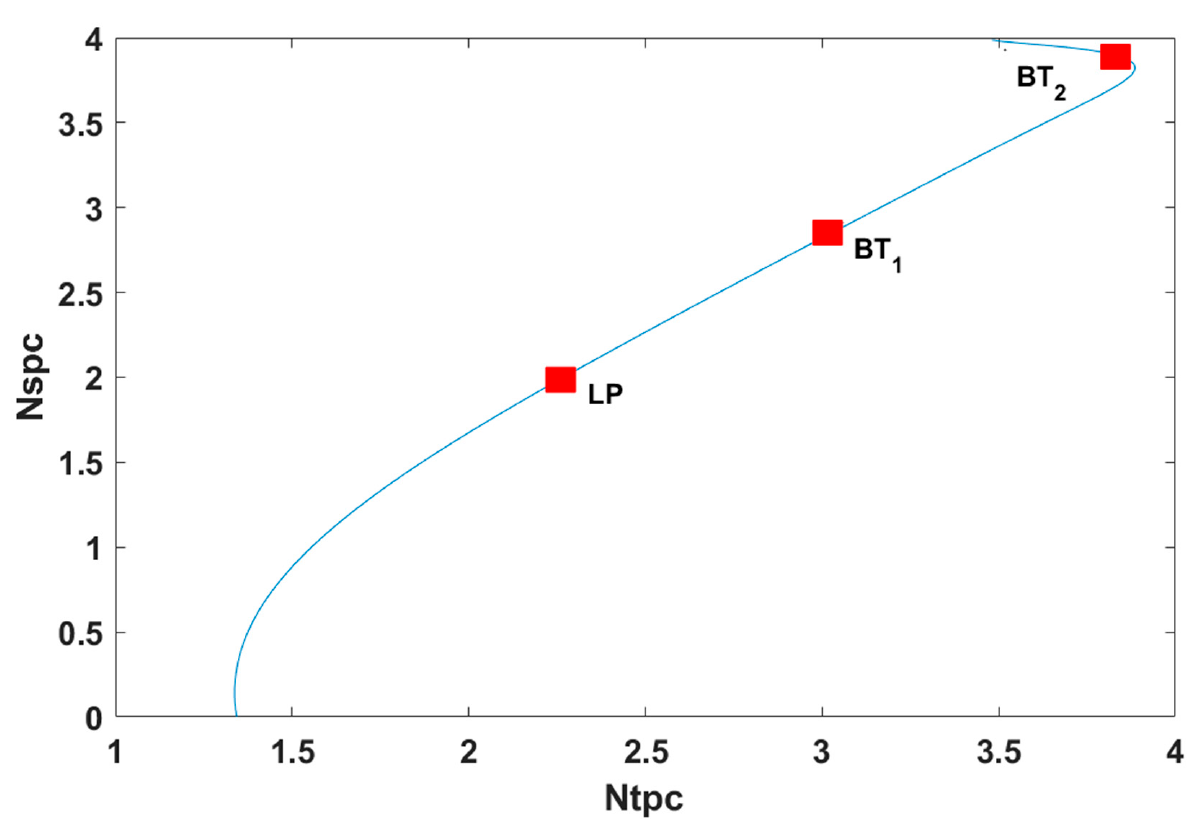
Figure 11. Stability boundary at high heat flux ratio on each channel.